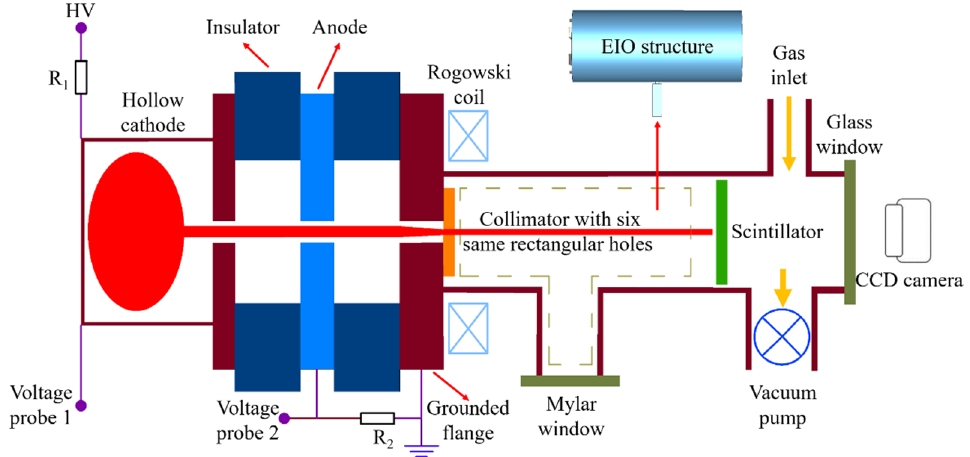
Figure 1. A schematic of the PS discharge system with a